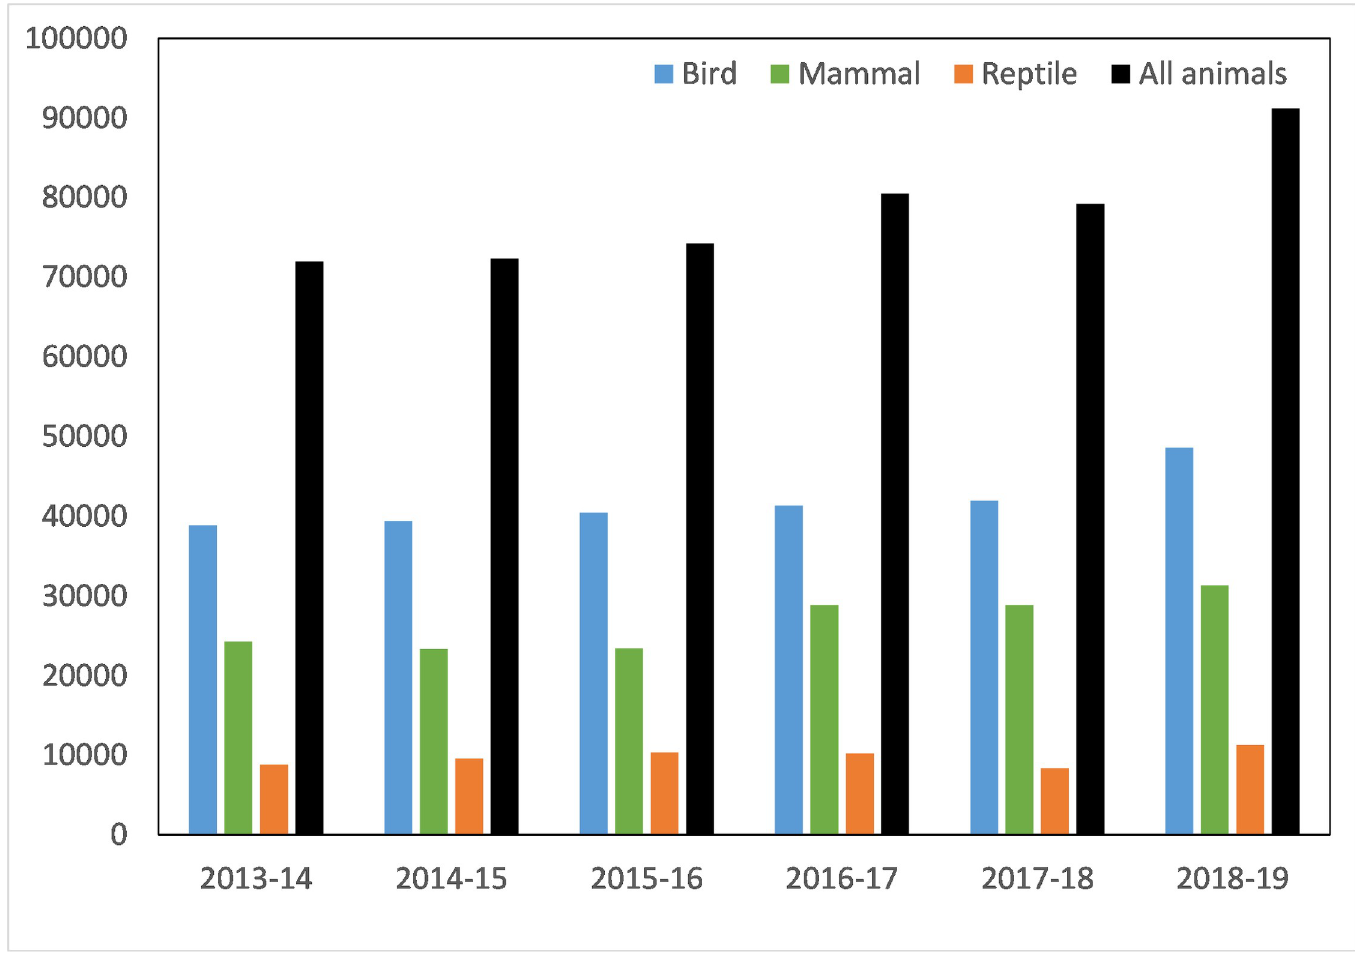
Fig 3. Number of rescue records per year for each animal group, and in